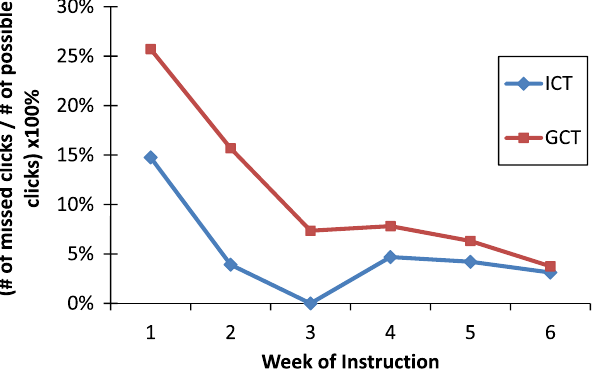
FIG. 12. Student nonresponse on ICT (blue) and GCT (red) as a percentage of total possible responses per week of instruction. The average standard error was (cid:2) 2 . 79 % for ICT and (cid:2) 3 . 86 % for